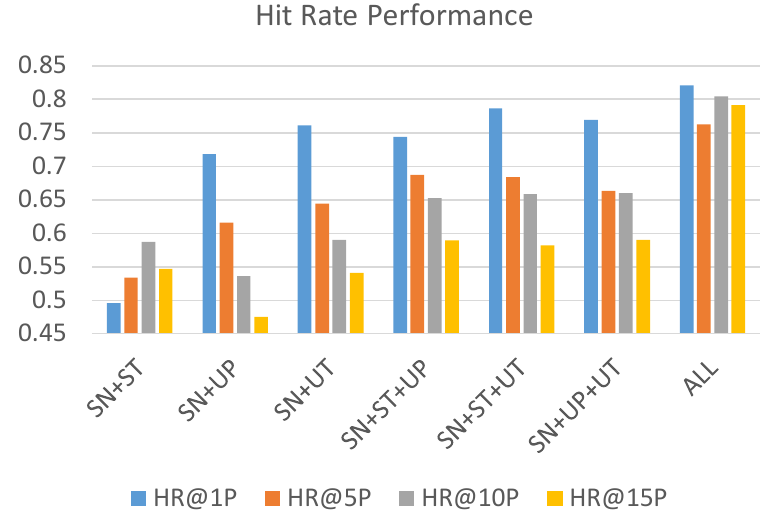
Figure 11. Hit rate performance of different component combinations.